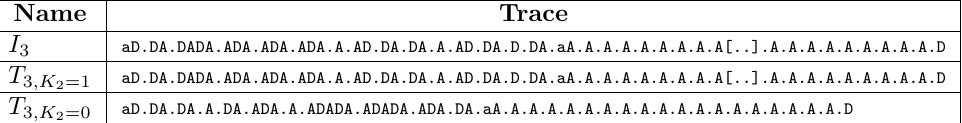
Table 5: Example traces from libgcrypt